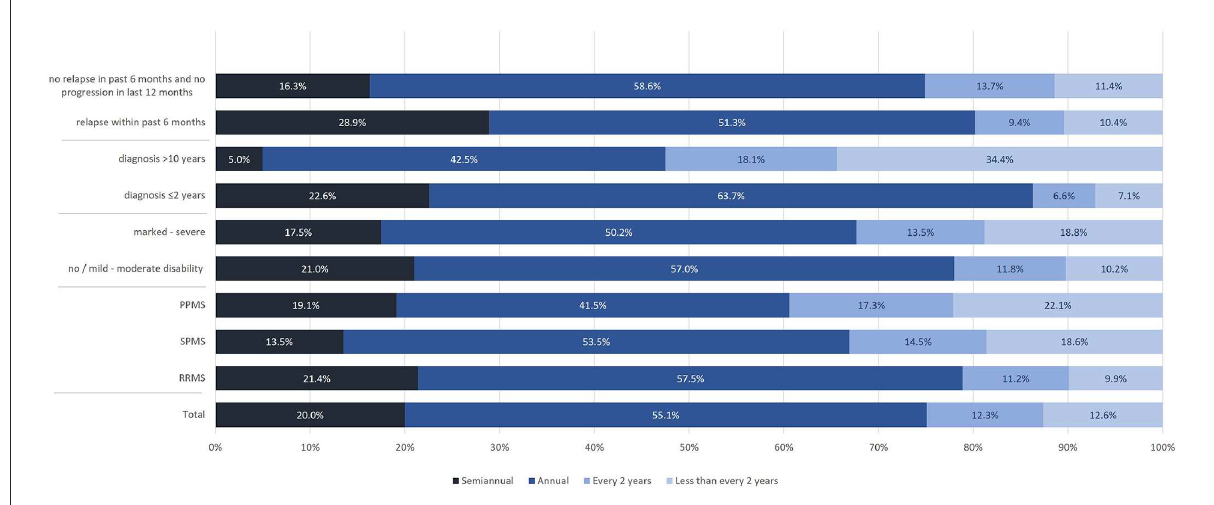
FIGURE9 Frequency of MRI assessments (total population, by subtype, by disease severity, by time of diagnosis, by relapse activity/progression).